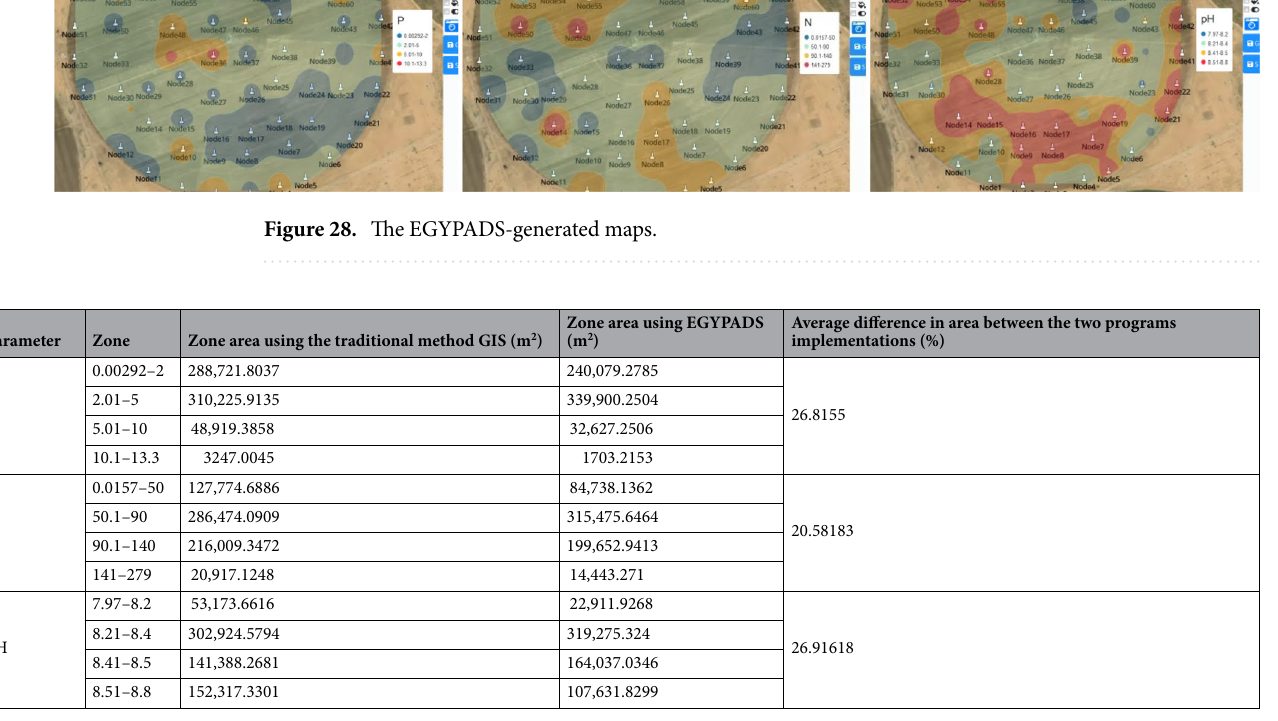
Table 7. Management zones areas resulted from the LSA